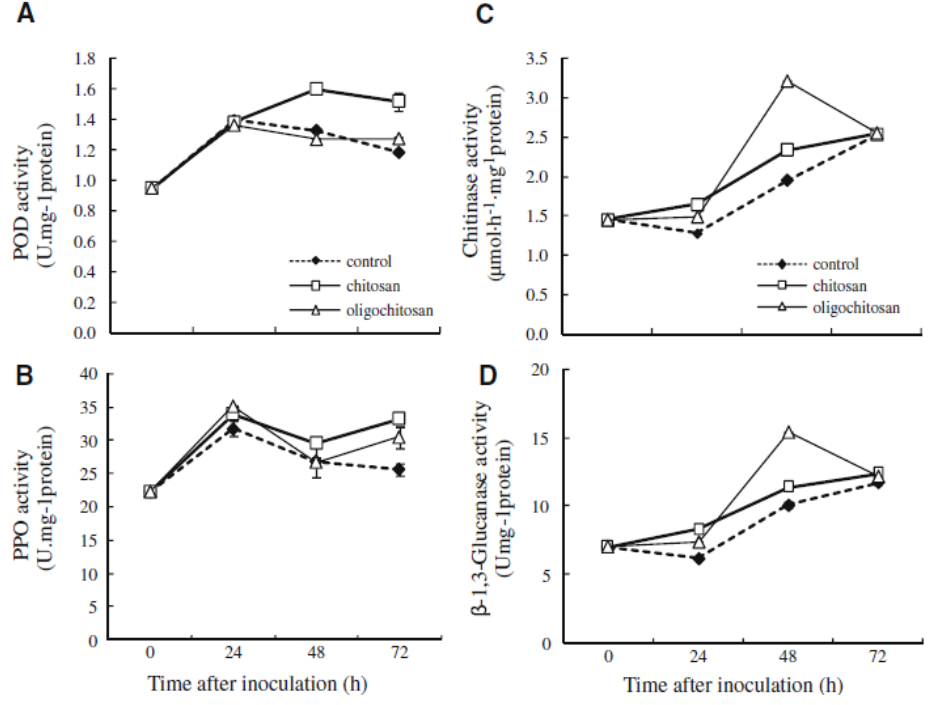
Figure 11. Effects of chitosan or oligochitosan on activities of POD ( A ), PPO ( B ), CHI ( C ) and β-1,3-glucanase ( D ) of pear fruit. Reproduced from Reference [87].